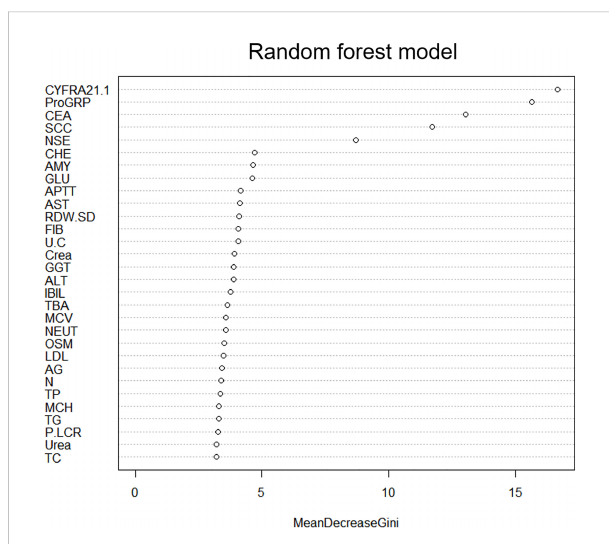
FIGURE 3 Performance of top-ranking variables selected by